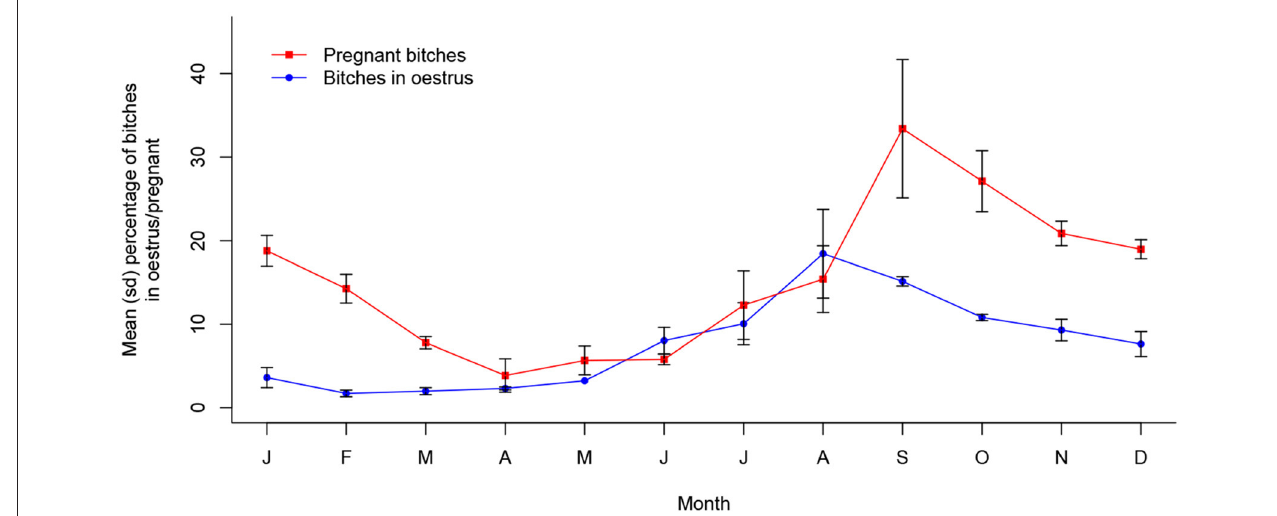
FIGURE 2 | Mean (sd) proportions of bitches in oestrus and pregnant in Jamshedpur, India between 2013 and 2016 ( n = 5,750).